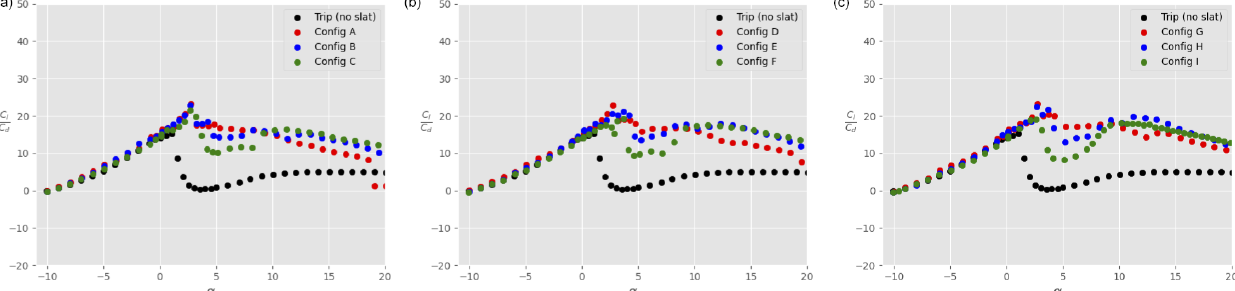
Figure 14. Lift-to-drag ratio C l /C d on the ensemble airfoil + slat as a function of the angle of attack α for different slat configurations, a tripped main airfoil, and Re = 1 . 5 × 10 6 : h slat /c main = 0 . 02 (a) , h slat /c main = 0 . 03 (b) , and h slat /c main = 0 . 04 (c) . The black data are taken without slat, while the coloured data are in the presence of a slat with β slat = 16 . 4 ◦ (red), β slat = 21 . 4 ◦ (blue), and β slat = 26 . 4 ◦ (green).